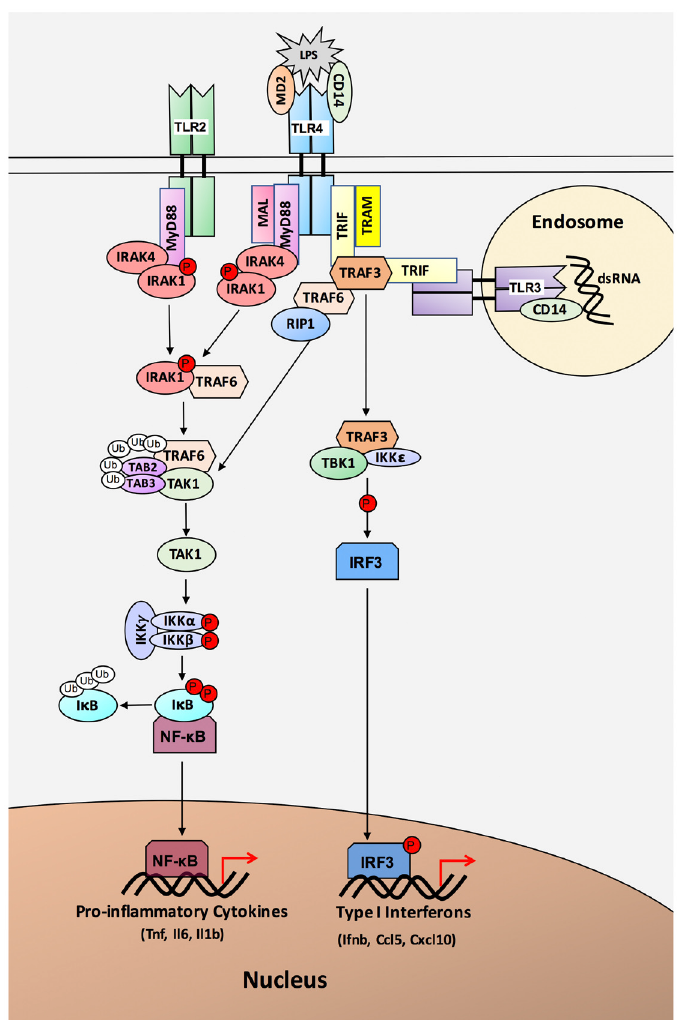
Figure 1. TLR-signaling pathways. Lipopolysaccharide (LPS) is recognized by TLR4 and its co-receptors MD2 and CD14. TLR4 signals through two different pathways, the MyD88-dependent pathway and the TRIF-dependent pathway. The MyD88-dependent pathway utilizes the adapter protein MyD88, which recruits IRAK4, IRAK1, and TRAF6. Phosphorylation of IRAK1 and ubiquitination of TRAF6 leads to activation of IKKs and NF- κ B. Activated NF- κ B translocates to the nucleus where it promotes transcription of pro-inflammatory cytokines. TLR2 also signals through the MyD88-dependent pathway. The TRIF-dependent pathway, utilized by TLR3 and TLR4, signals through the adapter protein TRIF. TRIF recruits TRAF6 and TRAF3. Signaling through TRAF6 leads to NF- κ B activation, while signaling through TRAF3 utilizes IKK ε to activate IRF3. Activated IRF3 translocates to the nucleus, where it leads to transcription of Type I interferons and interferon inducible